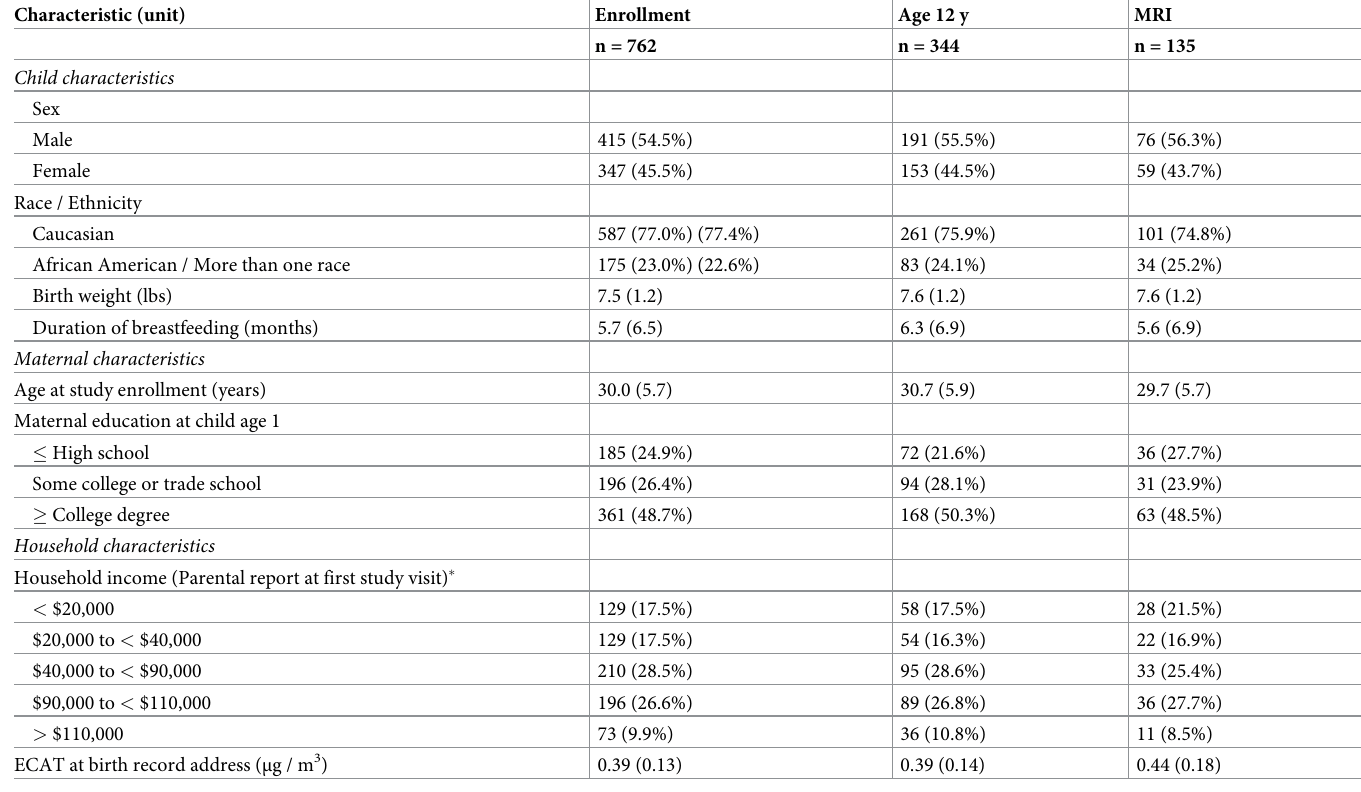
Table 1. Characteristics of CCAAPS participants at enrollment, age 12 y, and imaging subset [n(%) or mean (SD)]. Characteristic